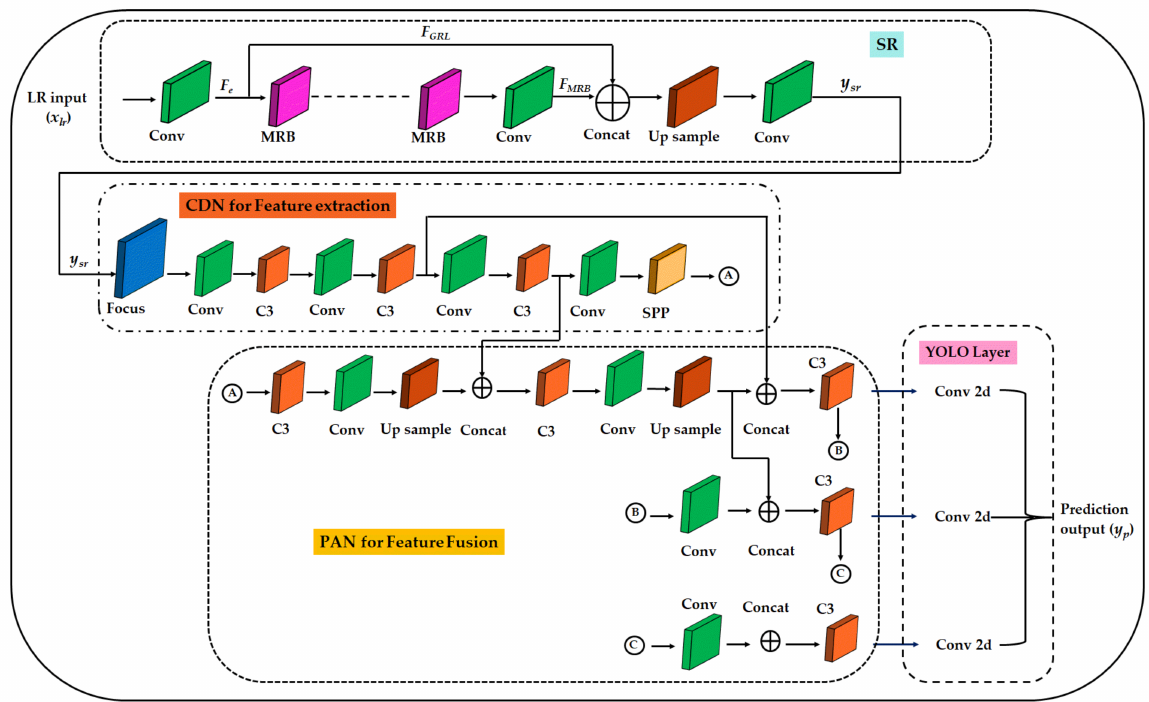
Figure 1. Proposed object detection network based on SR (SRODNet) for autonomous